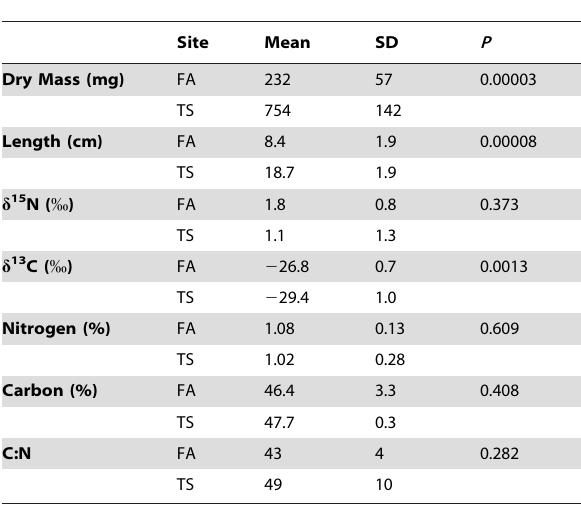
Table 1. Comparison of traits for pitchers of untreated plants ( N =5) harvested at Fort Albany, James Bay, Ontario, Canada (FA) and Tom Swamp, central Massachusetts, USA (TS) with significance level of unpaired t-test comparing